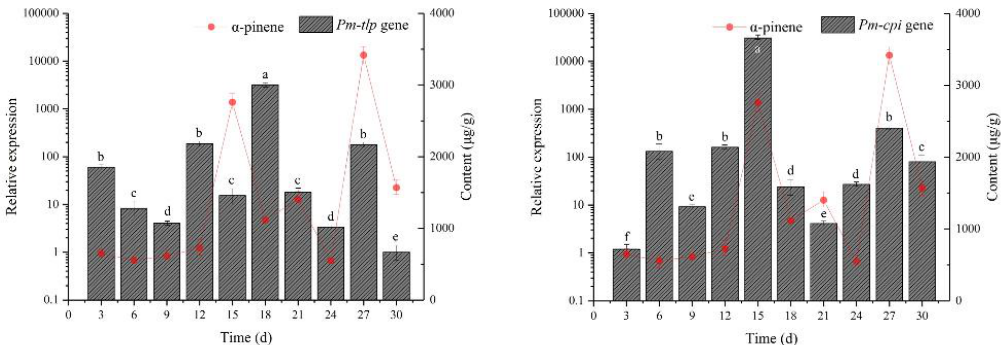
Figure 7. Expression analysis of the potential molecular mimicry proteins from B. xylophilus and P. massoniana. There were three biological replications for each experiment. The error line means standard deviation of the mean. Bars with different letters indicate significant differences among the treatments, as defined by Duncan’s test ( p < 0.05).